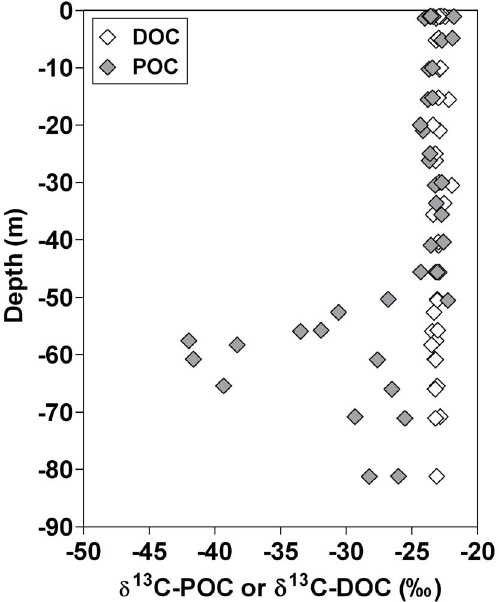
organic carbon (DOC) ( d 13 C-DOC, % ) and d 13 C signature of particulate organic carbon (POC) ( d 13 C-POC, % ) in the main basin of Lake Kivu in October